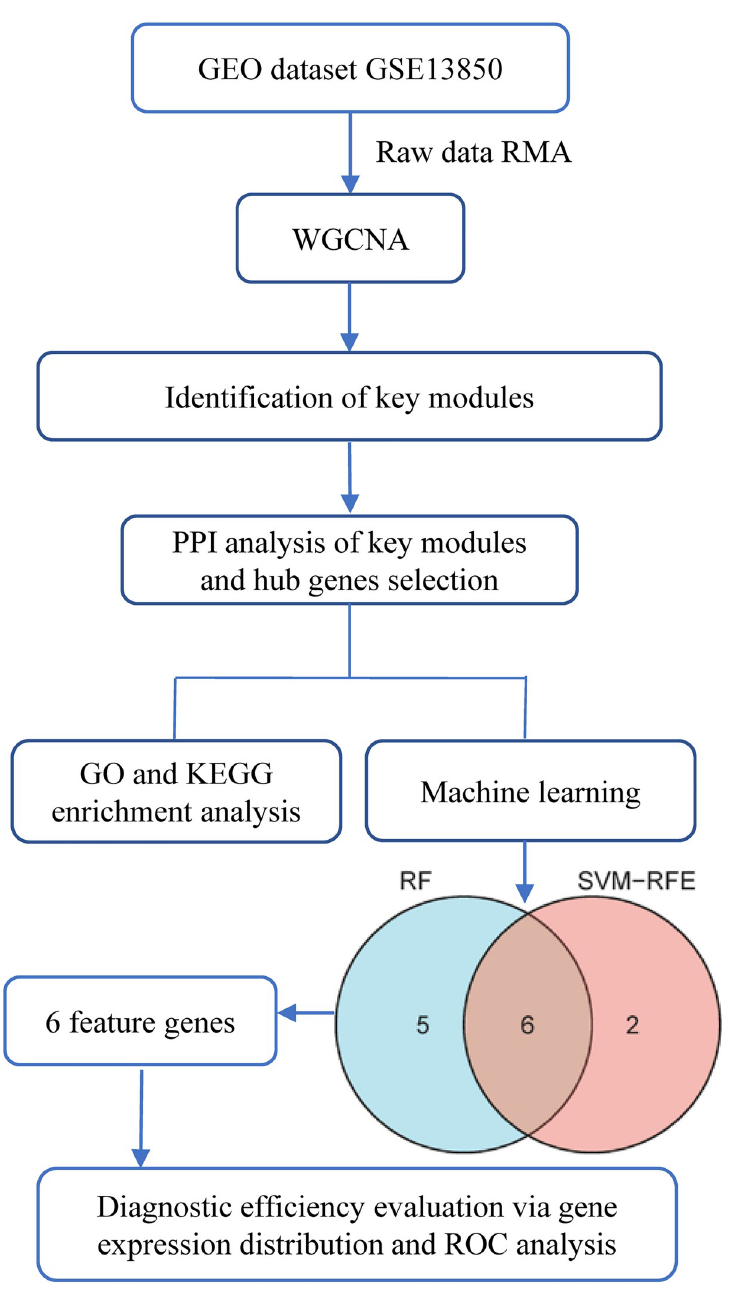
Fig 1. Workflow of the present